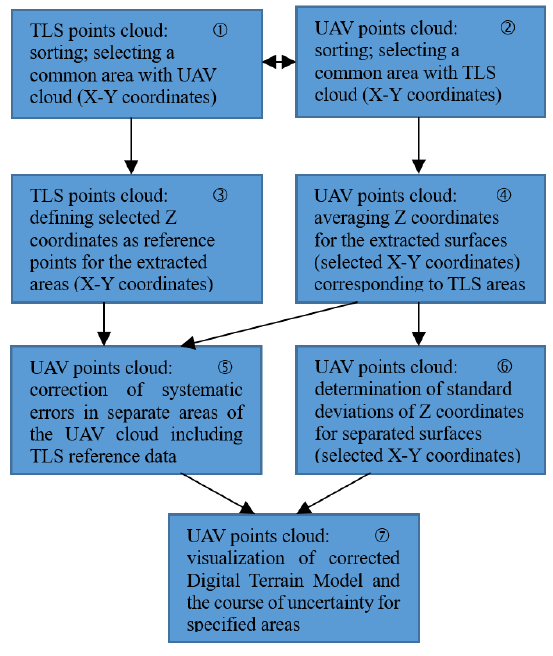
Figure 8. A scheme of actions to be taken to improve the UAV terrain model.